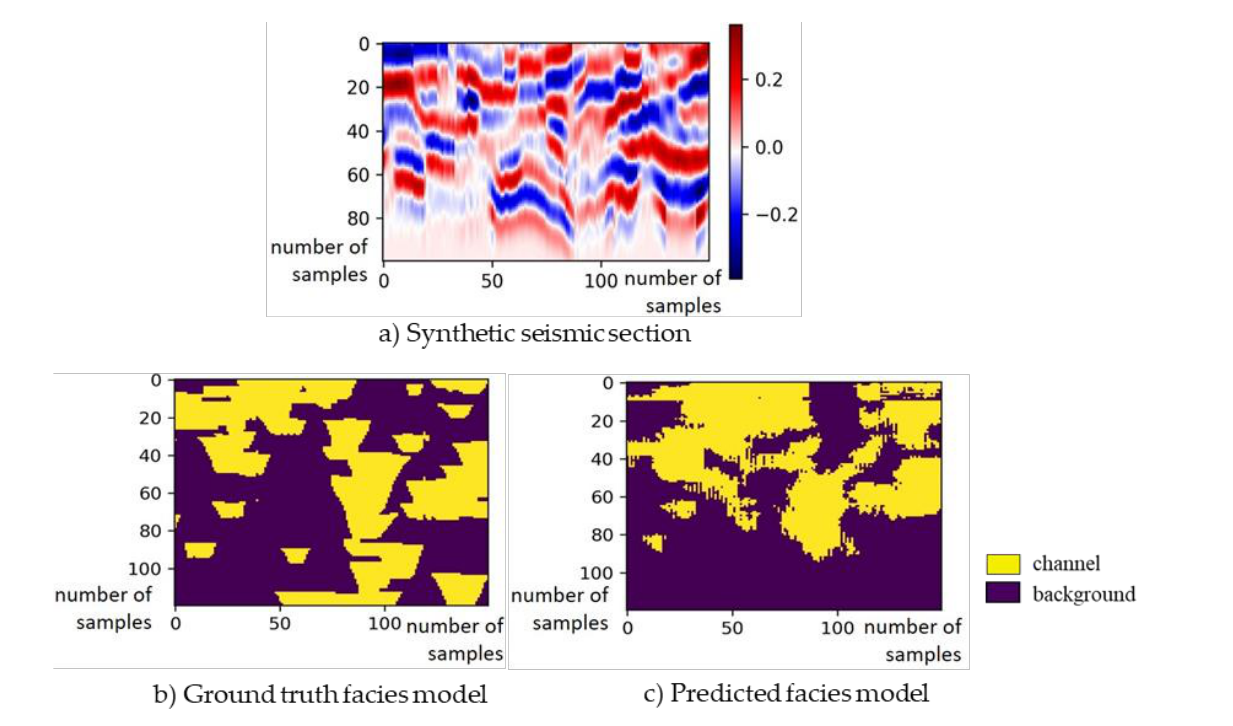
Figure 17. Synthetic seismic section ( a ), ground truth facies model ( b ) and predicted result ( c ). The data is 2D in nature, which does not allow the model to leverage its spatial awareness.